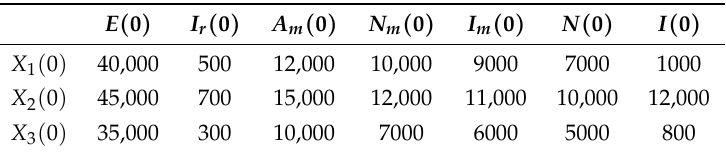
Figure 3. The solution of Model (5) tends toward the disease-free equilibrium. In this figure, we show the evolution of the infected humans population for different initial conditions. Table 1. Initial conditions